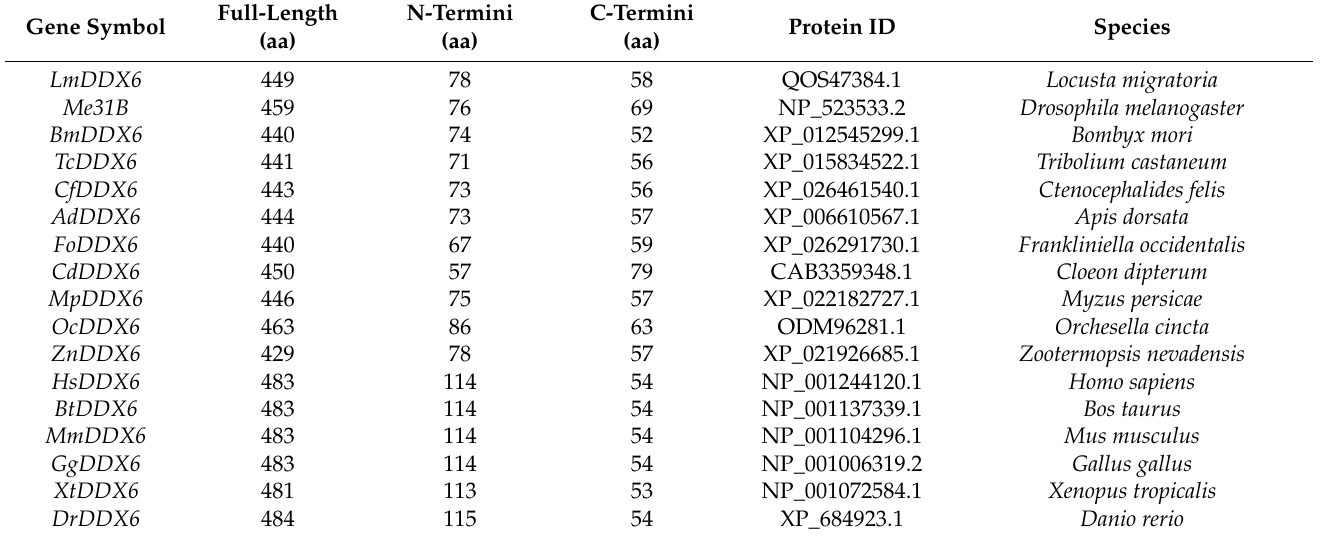
Table 1. List of the genes analyzed in the phylogenetic